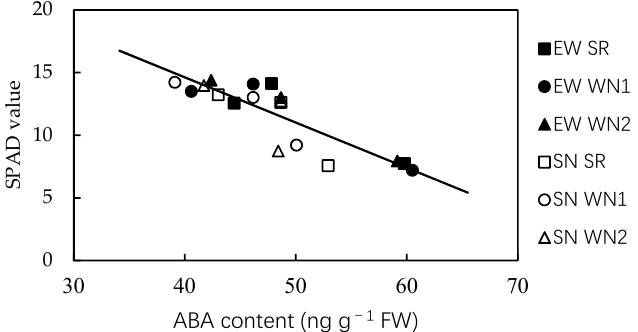
Figure 7. Relationship between abscisic acid (ABA) concentration and chlorophyll content (SPAD value) at days after silkng (DAS) 12, 22, and 40 of maize under two row directions and three plant spacings (EW and SN indicate row direction of east to west and south to north, respectively. SR indicates single rows spaced at 65 cm; WN1 indicates 40 cm twin rows spaced at 90 cm between the paired rows of narrow–wide rows; and WN2 indicates 40 cm twin rows, spaced at 160 cm between the paired rows of narrow–wide rows).